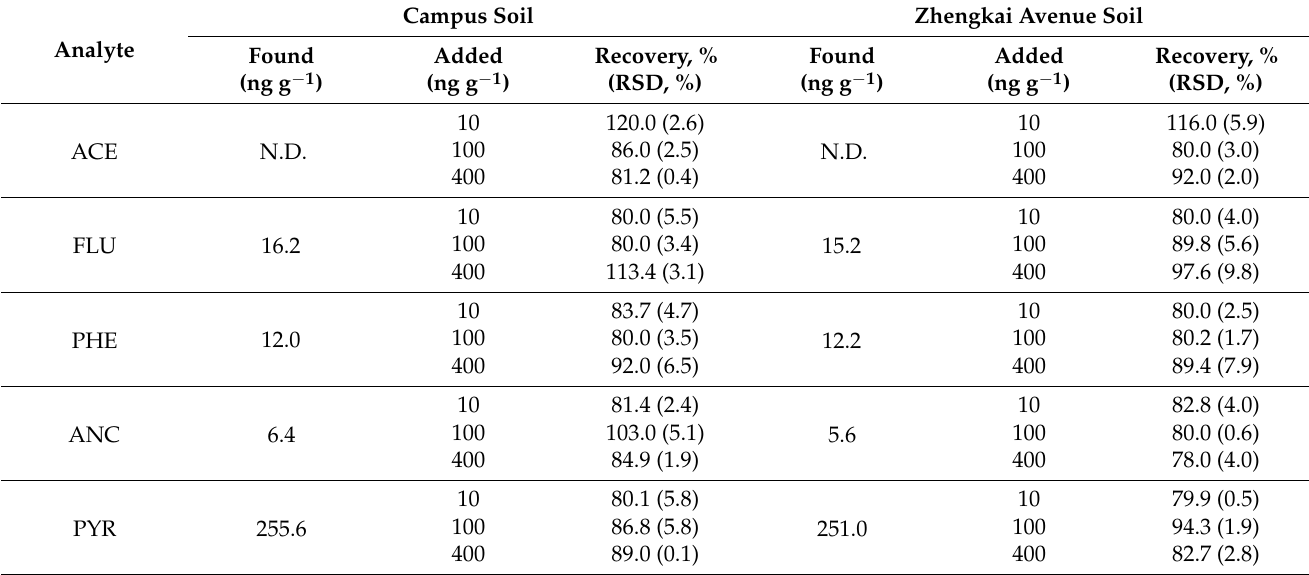
Table 3. The contents of target PAHs in real samples and recoveries.